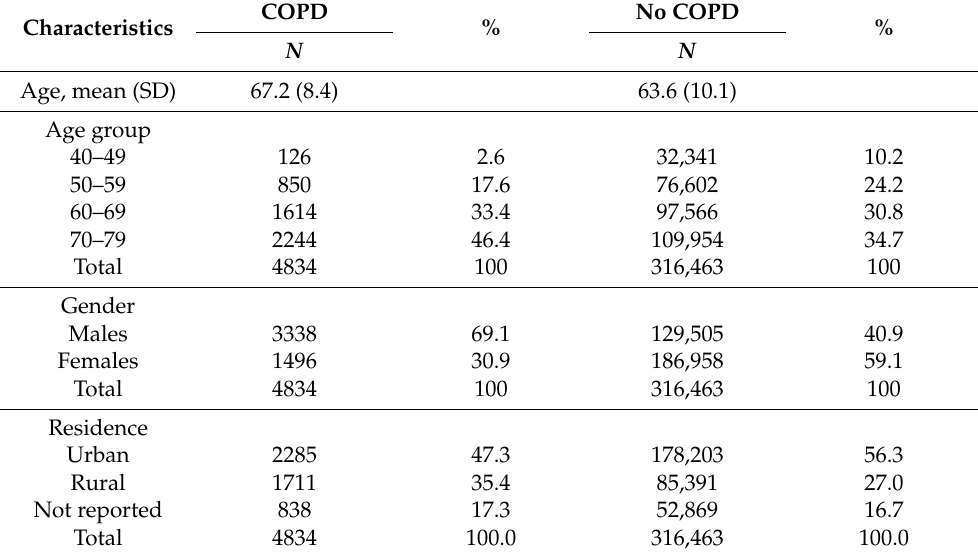
Table 1. Study population characteristics.